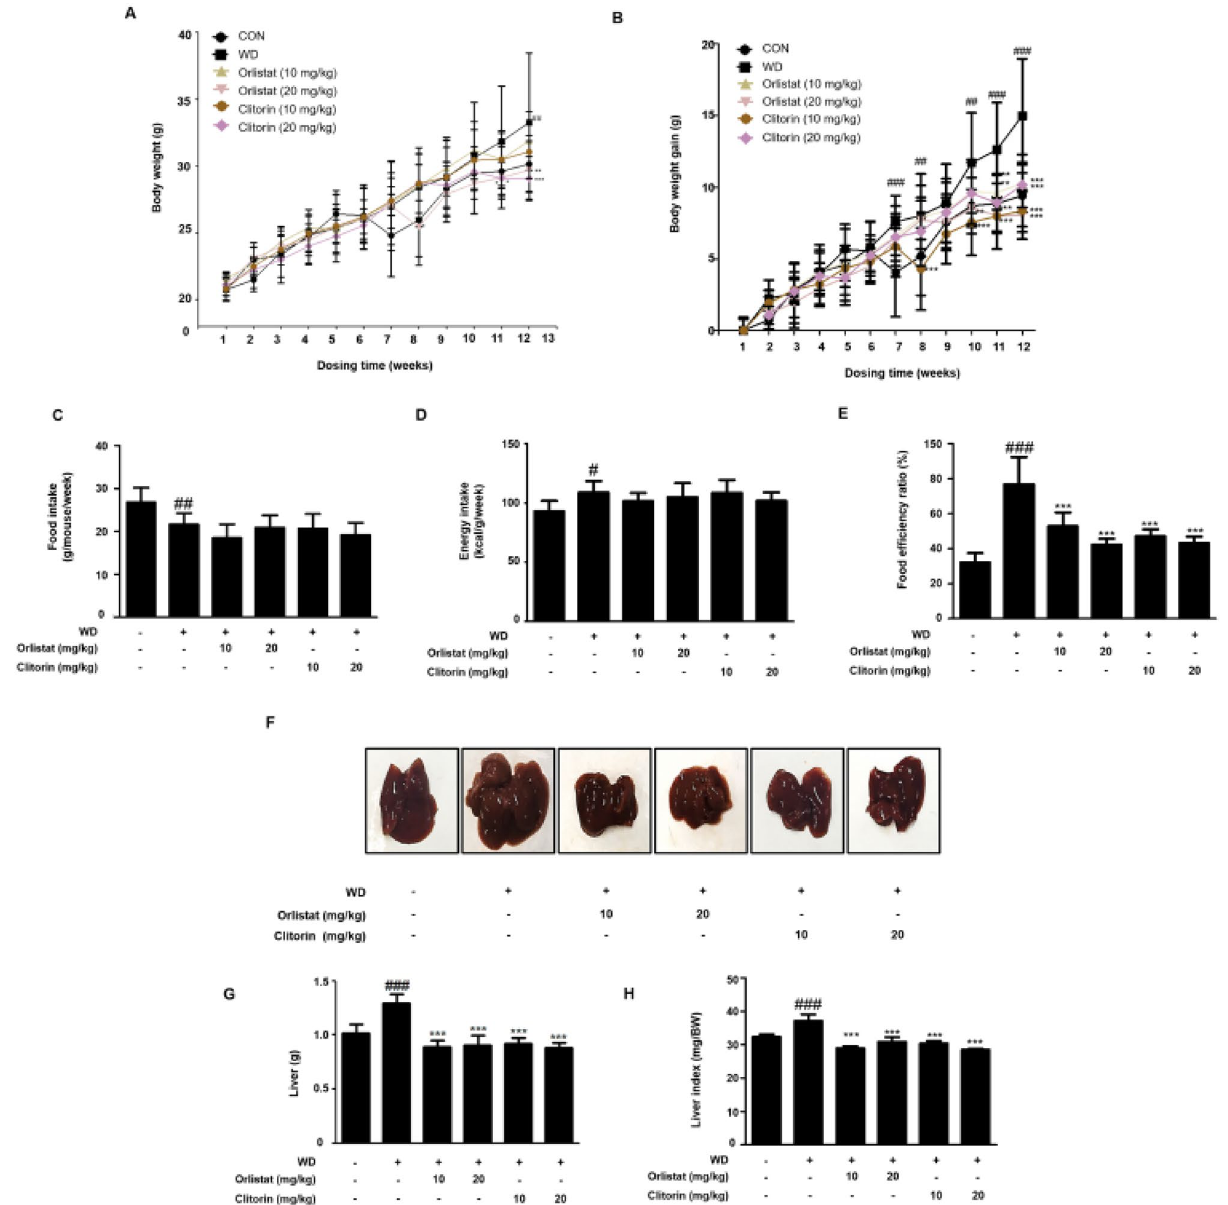
Figure 2. Effect of clitorin on total body weight, weight gain, and food intake in the WD-induced obese mouse model. The WD-induced mice were administered orlistat (10 or 20 mg/kg) or clitorin (10 or 20 mg/kg) for 4 weeks, whereas control mice were fed a normal diet. ( A ) Body weight and ( B ) weight gain were recorded every week. ( C ) Food intake and ( D ) energy intake were calculated. ( E ) Food efficiency ratio (FER) was calculated by applying the equation: FER = (body weight gain (g)/food intake (g)) × 100. ( F ) Macroscopic images in the liver of mice in each group were taken at the end of the 13-week experimental period. ( G ) The weight of liver tissue and ( H ) relative liver weight ratio (mg/body weight) were measured. The values are represented as the mean ± SD (n = 6 per group). # P < 0.05, ## P < 0.01, and ### P < 0.001 vs. CON group; *P < 0.05, **P < 0.01, and ***P < 0.001 vs. WD group; significance was determined using two-way ANOVA followed by a Bonferroni post hoc test, and one-way ANOVA followed by Dunnett’s post hoc test. WD western diet, FER food efficiency